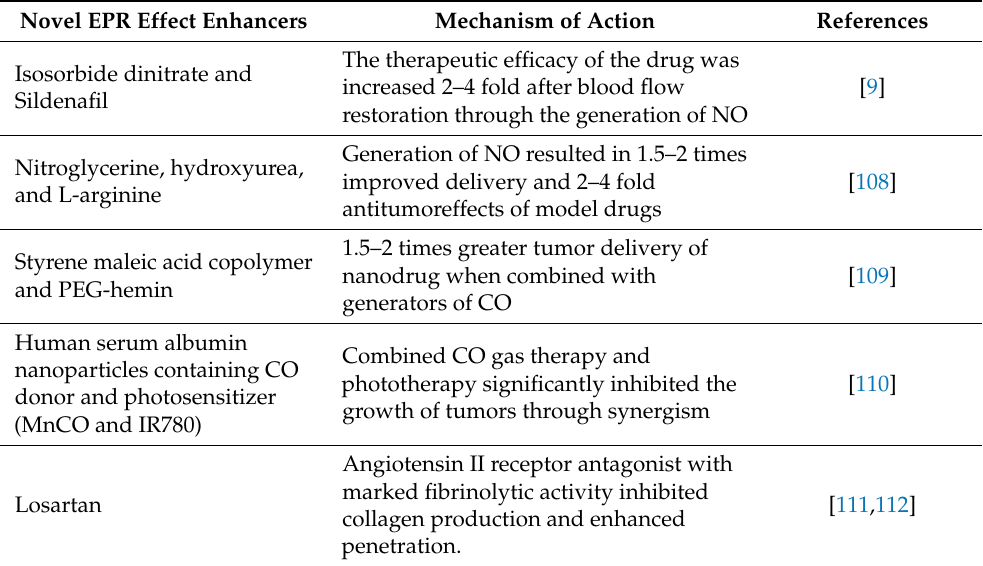
Table 2. Types of EPR-effect enhancers and mechanism of action